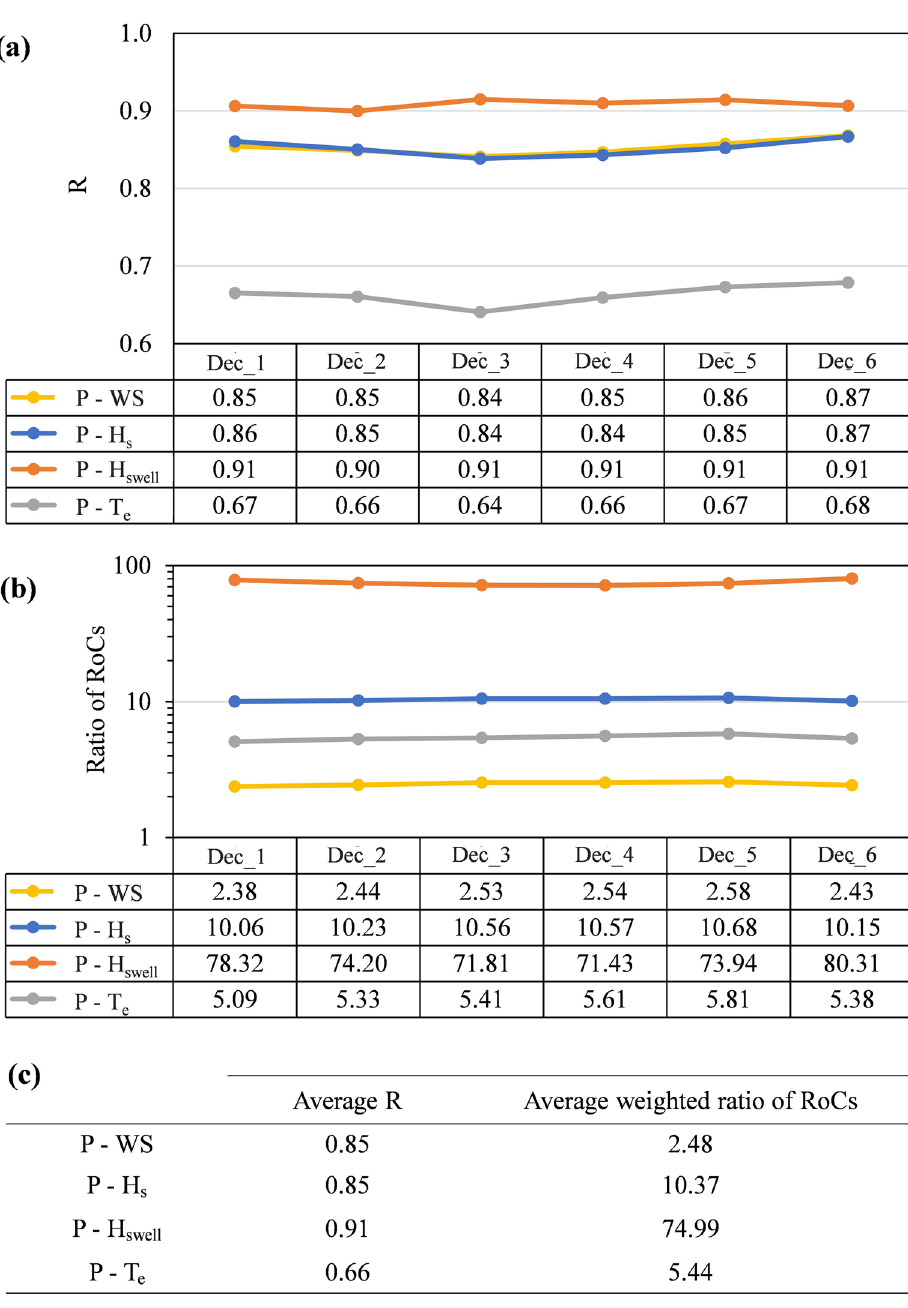
Figure 5. Decadal variation of ( a ) correlation coefficient (R) of RoCs and ( b ) ratio of RoCs, for P and wind or wave parameters and ( c ) the average